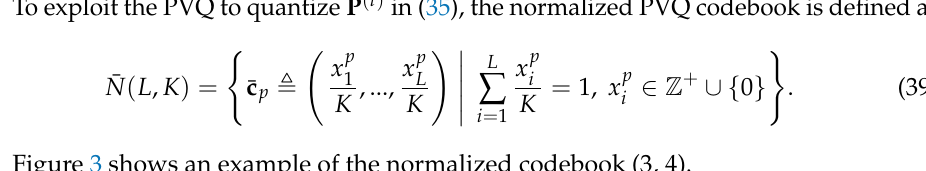
Figure 2. Codebook of pyramid vector quantization, L = 3, K = 4.